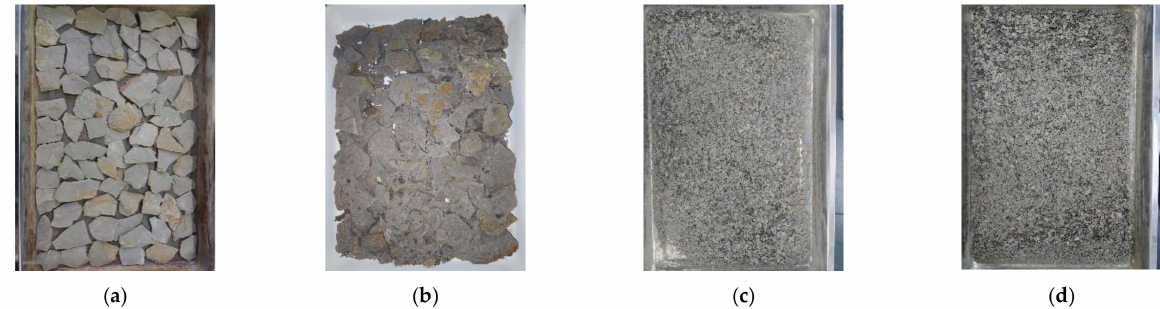
Figure 6. Disintegration process of carboniferous shale after initial water immersion: ( a ) initial test specimen; ( b ) the first dry–wet cycle; ( c ) the 5th dry and wet cycle; ( d ) the 8th dry and wet